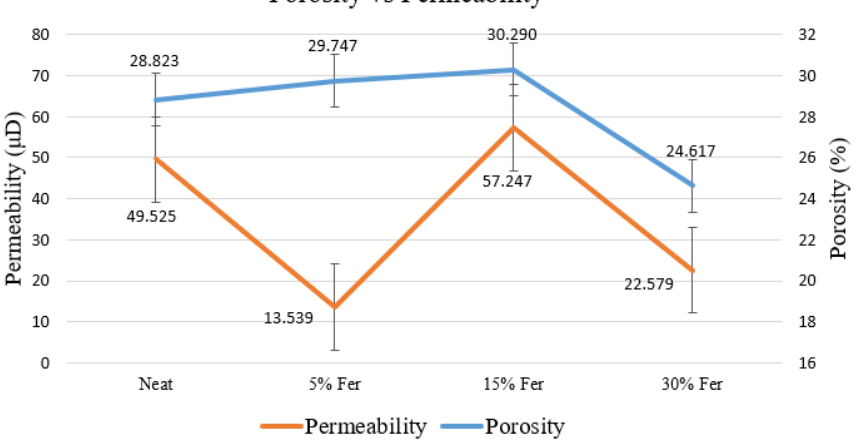
Figure 16. Average porosity and permeability values of 5%, 15% and 30% FER-added and neat Class-H cement measured using Core Lab UltraPore 300 Porosimeter and Nan-Perm Permeameter. Although 30% ferrierite has the least porosity due to better hydration, the 5% ferrierite addition shows the best zonal isolation as it has the least permeability of 13.54 µ D in comparison to neat Class-H cement (49.53 µ D).